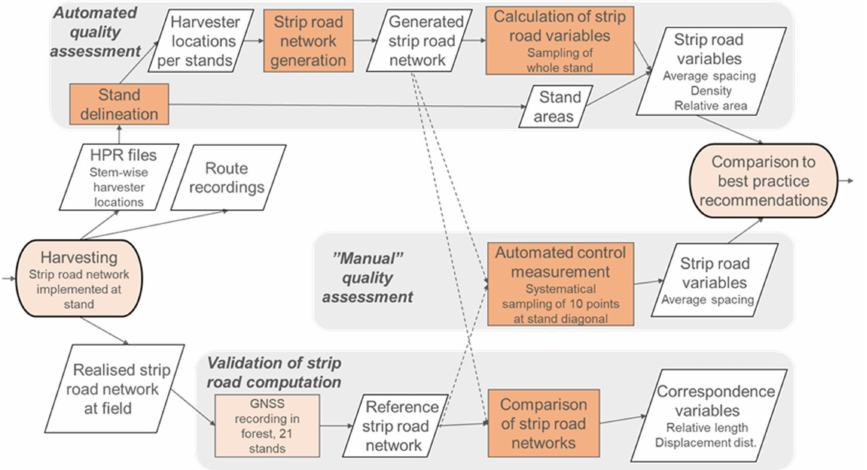
Figure 2. The workflow of the processes in this study: automated quality assessment, manual quality assessment and validation of strip road generation. The gray-shaded boxes indicate manual processes and the brown boxes indicate automated processes. White parallelogram boxes indicate data objects.